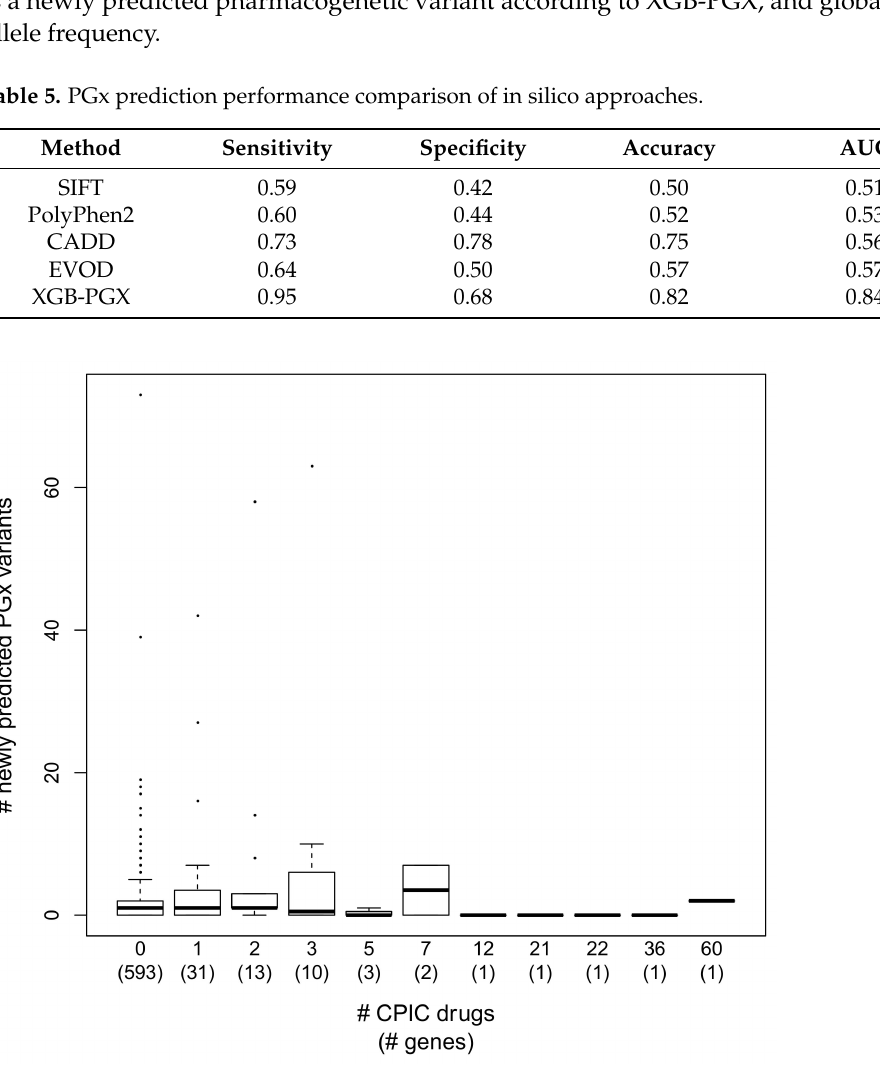
Figure 2. Boxplots of newly predicted pharmacogenetic variants across CPIC drug annotation